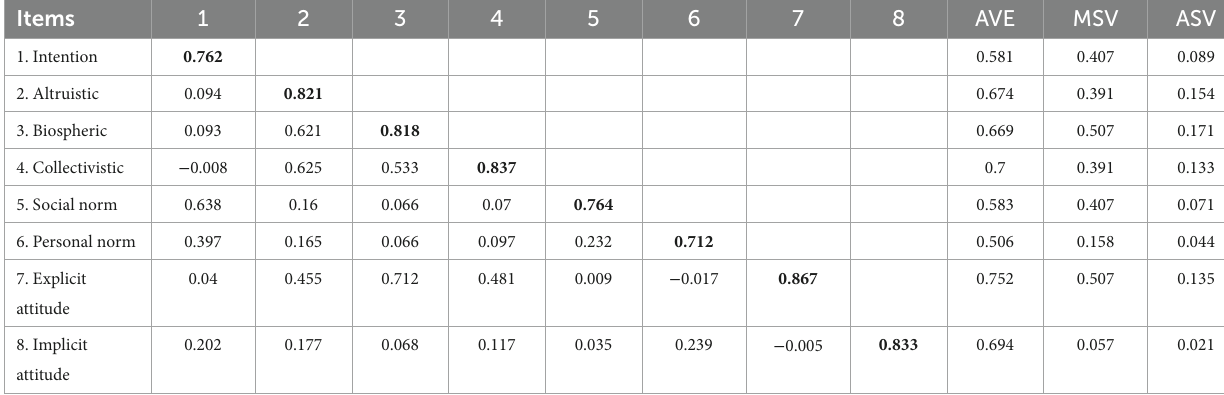
TABLE 3 Correlation between variables and discriminate validity.